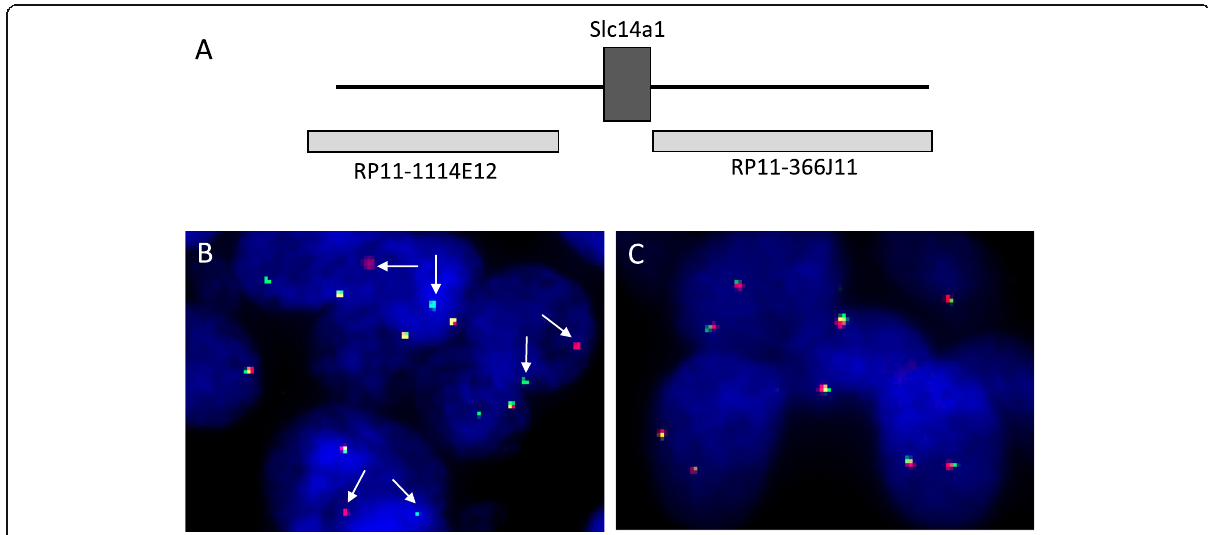
Fig. 2 FISH analysis using “ break-apart ” Slc14a1 gene probes. a . Illustration of FISH probe design and probe location. b . UT-B gene split was identified showing separated red dots and green dots (arrows) in cancer cells. c . Control. A representative image of UBC cell without UT-B gene split from a different patient. Normal signals are two close red and green colors with partial overlapped yellow